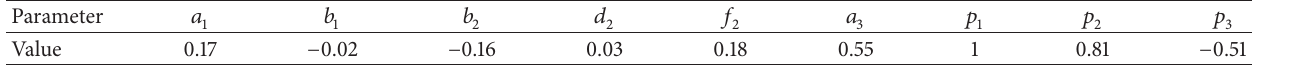
Table 6: Parameters in the proposed method.